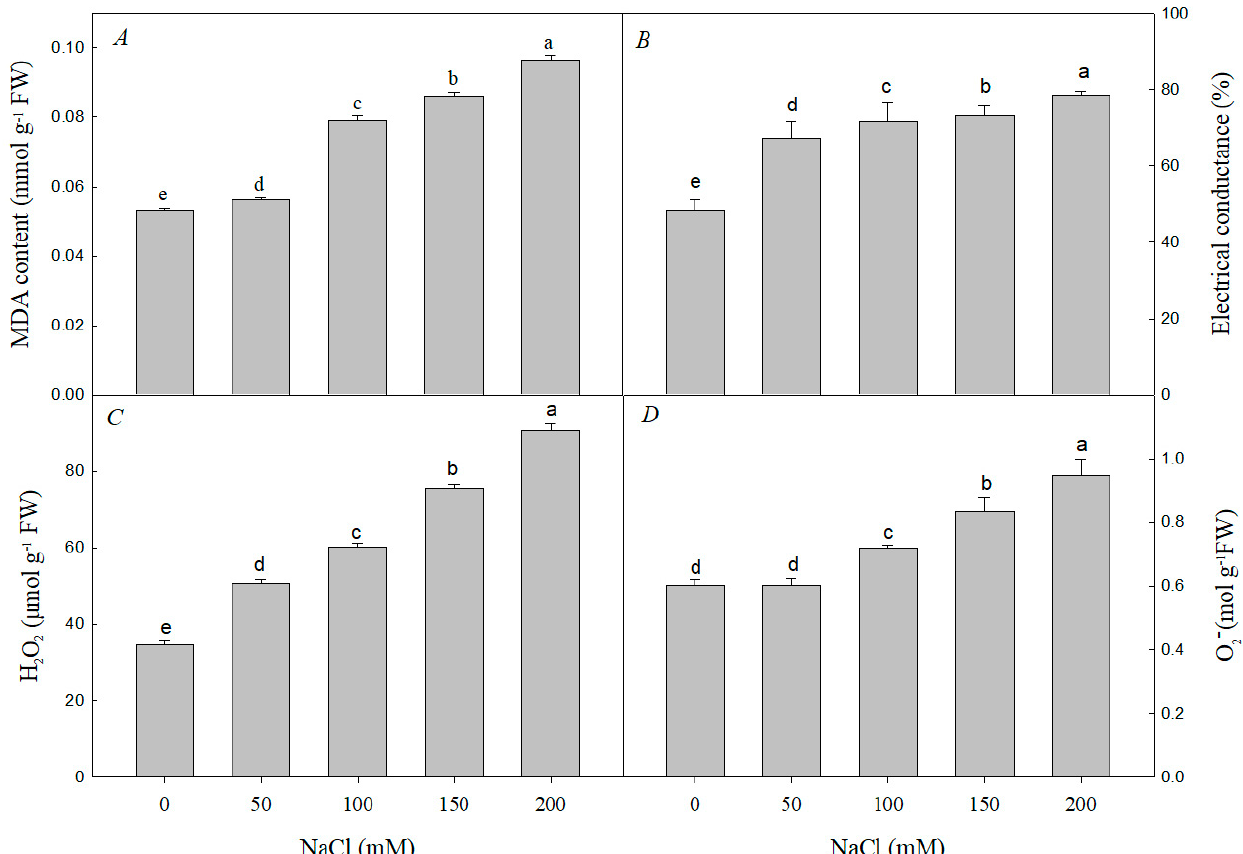
Figure 4. Effect of NaCl stress on the MDA content ( A ), electrical conductance ( B ), H 2 O 2 content ( C ), and O 2 − content ( D ) of R. pseudoacacia seedlings. Values are mean ± SD of five biological replicates. Bars with different letters are significantly different at p < 0.05 according to Duncan’s multiple range tests.